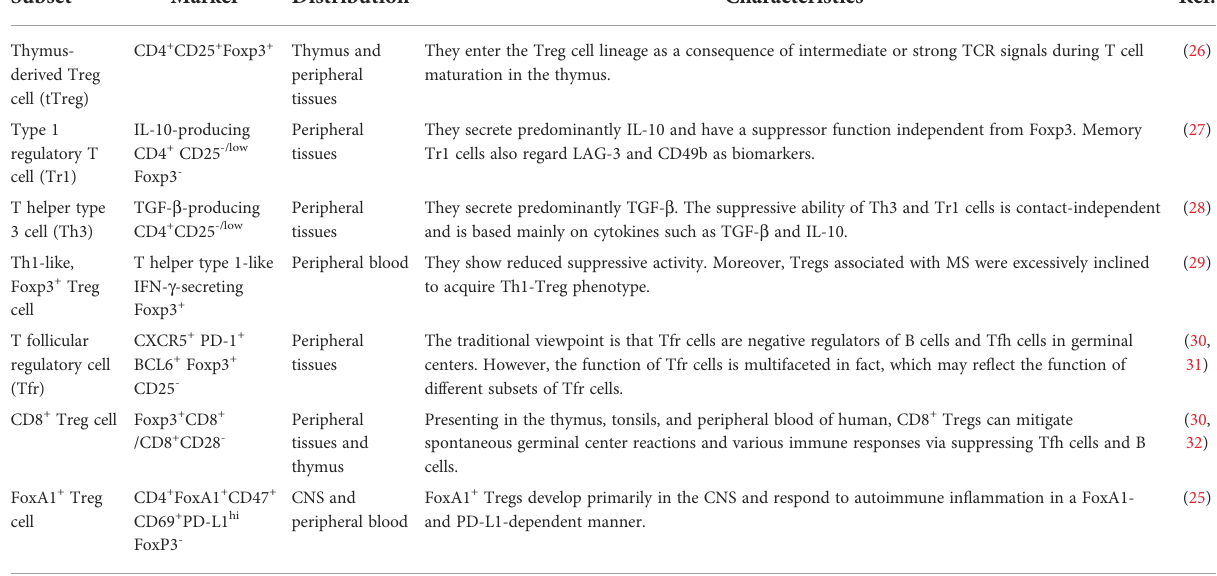
TABLE 2 Human regulatory T cell subsets related to multiple